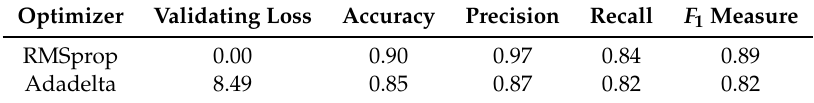
Table 3. Performance of the proposed CNN model for the fluorescence cell